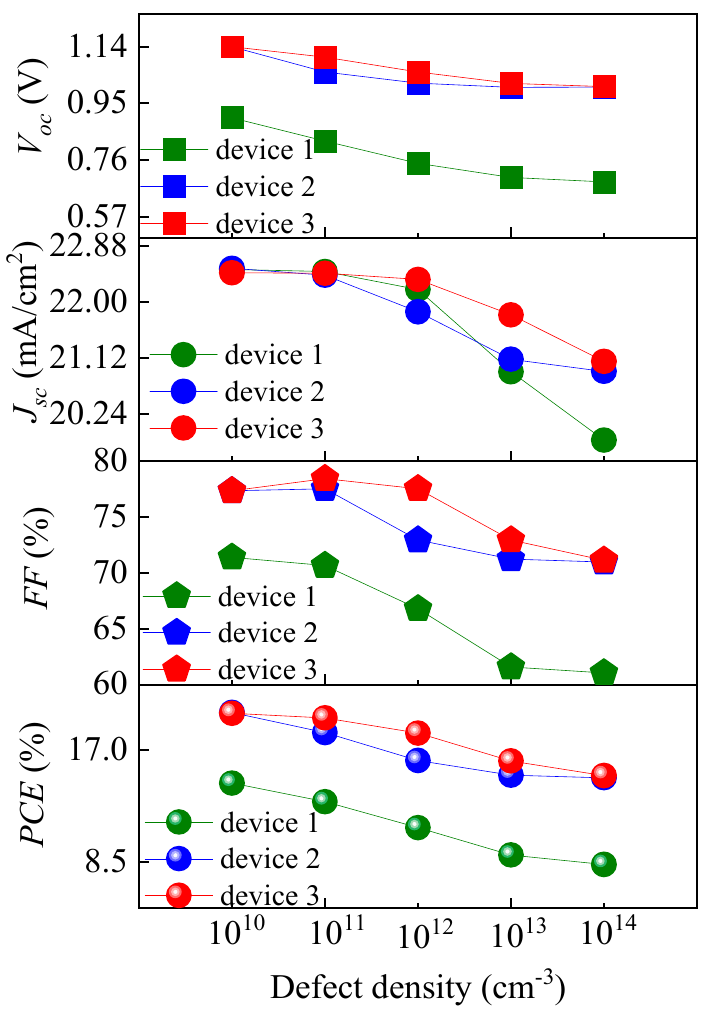
Figure 16. Effects of N it on the cell output parameters. Table 4. Decreases in output parameters.